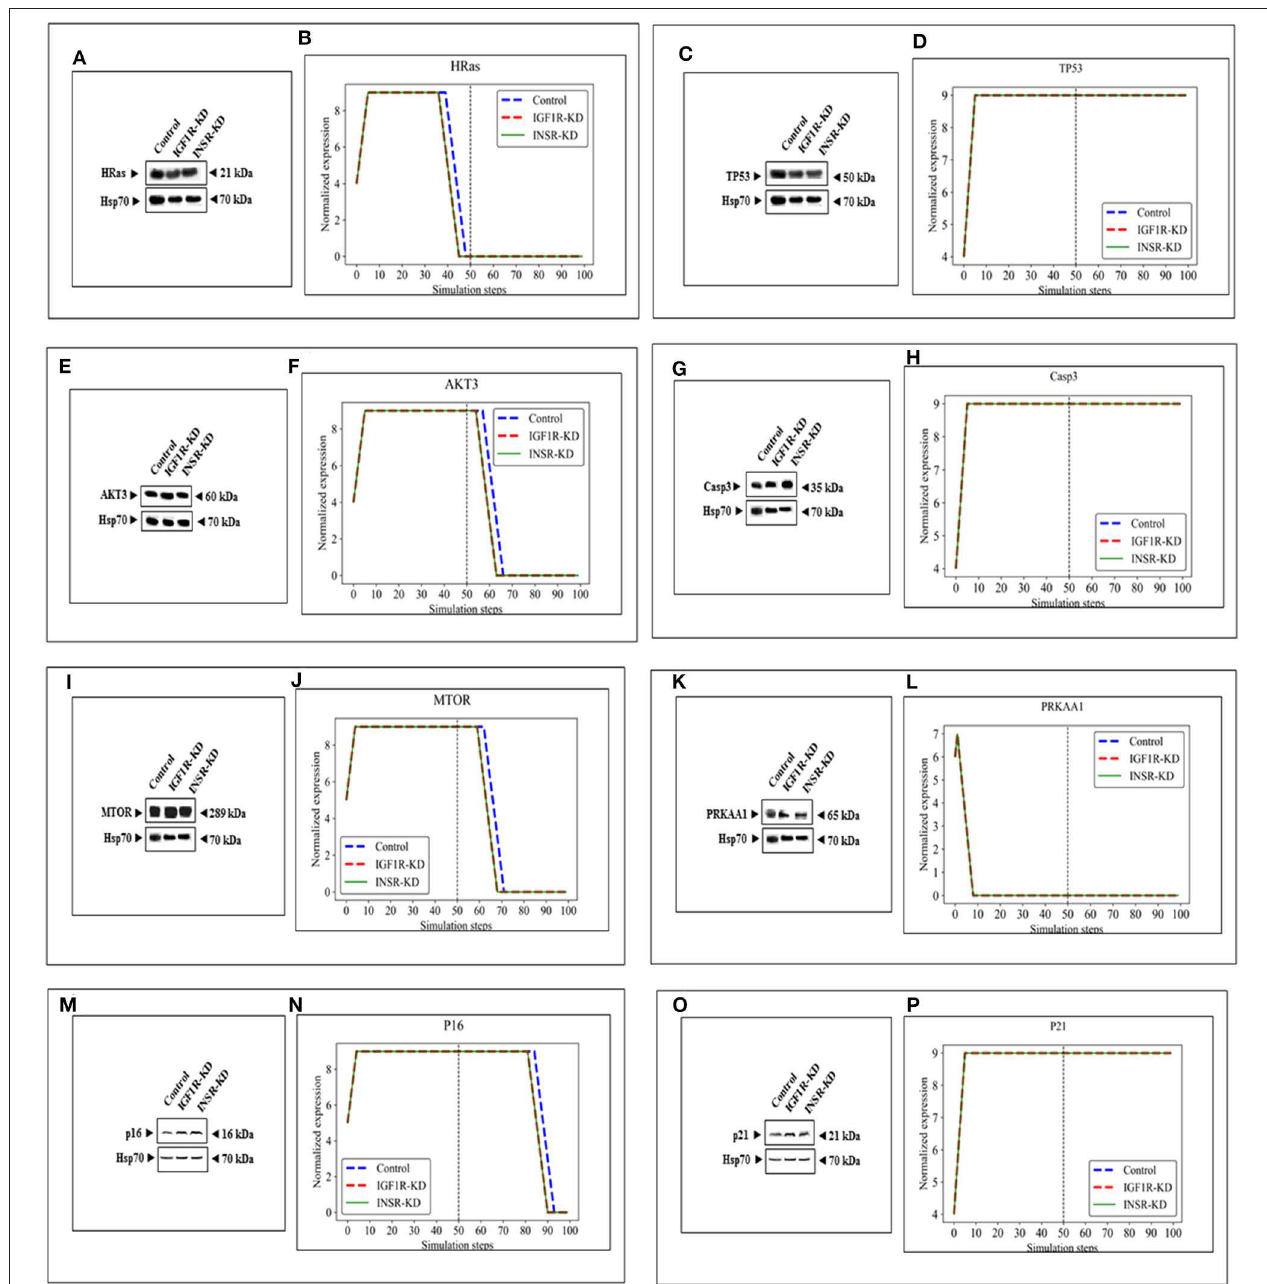
FIGURE 4 | Eight selected genes that do not change between control and KDs: BioNSi simulations validated by Western blots. Western blot analyses showing expression of HRas (A) , TP53 (C) , AKT3 (E) , CASP3 (G) , MTOR (I) , PRKAA1 (K) , p16 (M) , and p21 (O) proteins were conducted on whole cell lysates of Control, IGF1R-KD, and INSR-KD cells. Hsp70 was used as a loading control. Data are representative of two independent experiments. (B,D,F,H,J,L,N,P) BioNSi plots of normalized expression values against 100 simulation steps in Control (blue), IGF1R-KD (red), and INSR-KD (green) cells. A dashed vertical line indicates 50 steps of simulation. Splicing has occurred in the blot figures and full scans of the entire original (unprocessed) gels are presented in Supplementary Material . Squares in the uncropped films denote bands shown in the final